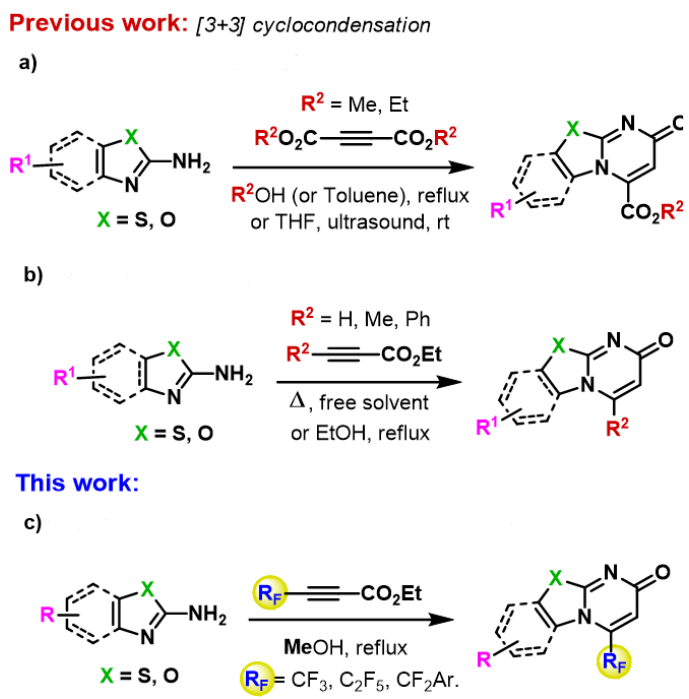
Figure 2. Convergent approach for the synthesis of thiazolo- and oxazolo[3,2-a]pyrimidinone de- rivatives. ( a ) from symmetric alkyne[28–36]; ( b ) from asymmetric alkyne [37–40]; ( c ) extension to fluorinated ethyl propiolate derivatives.